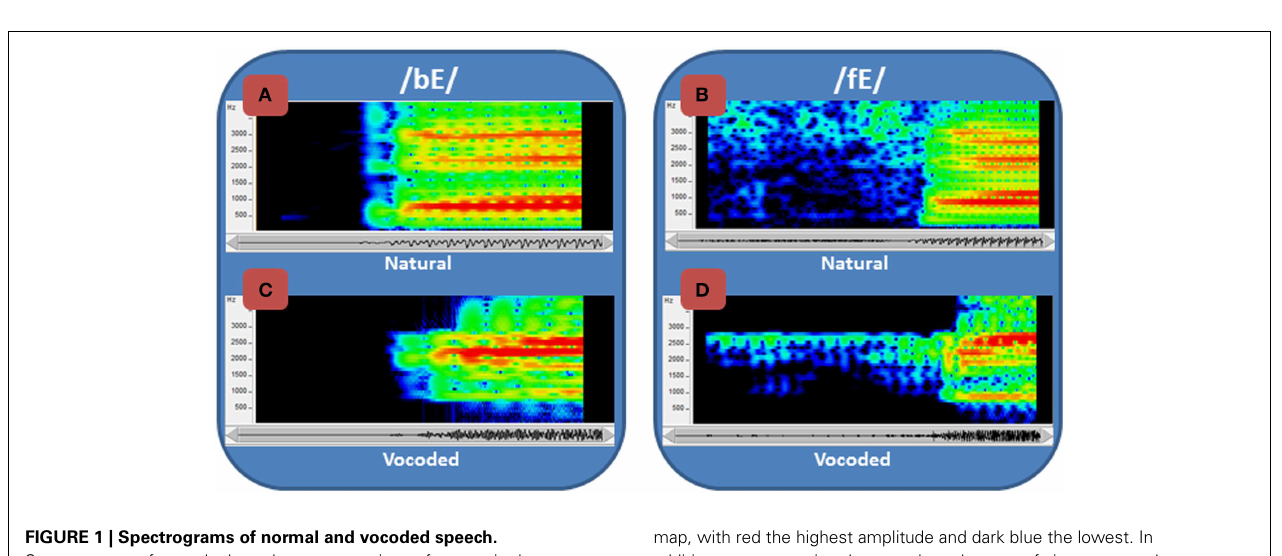
FIGURE 1 | Spectrograms of normal and vocoded speech. Spectrograms of speech show the concentrations of energy in the spectra over time.Two speech tokens, /bE/ and /fE/ (i.e., the vowel in “bet”), are shown in spectrograms of the natural (A) and (B) recorded speech and the vocoded (C) and (D) speech.The frequency range of the spectrograms is restricted to 4kHz, because all of the energy from the vocoder is similarly limited.The amplitudes are represented as a heat